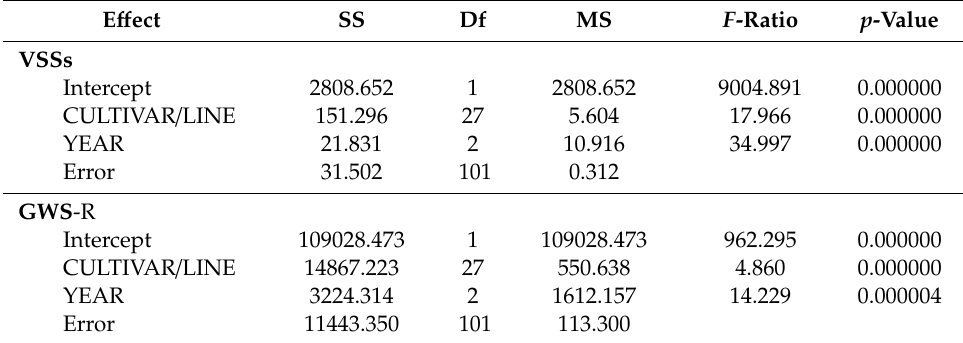
Table 2. Results of analyses of variance ( F -value) for visual symptom scores (VSSs) and grain weight per spike (GWS-R). E ff